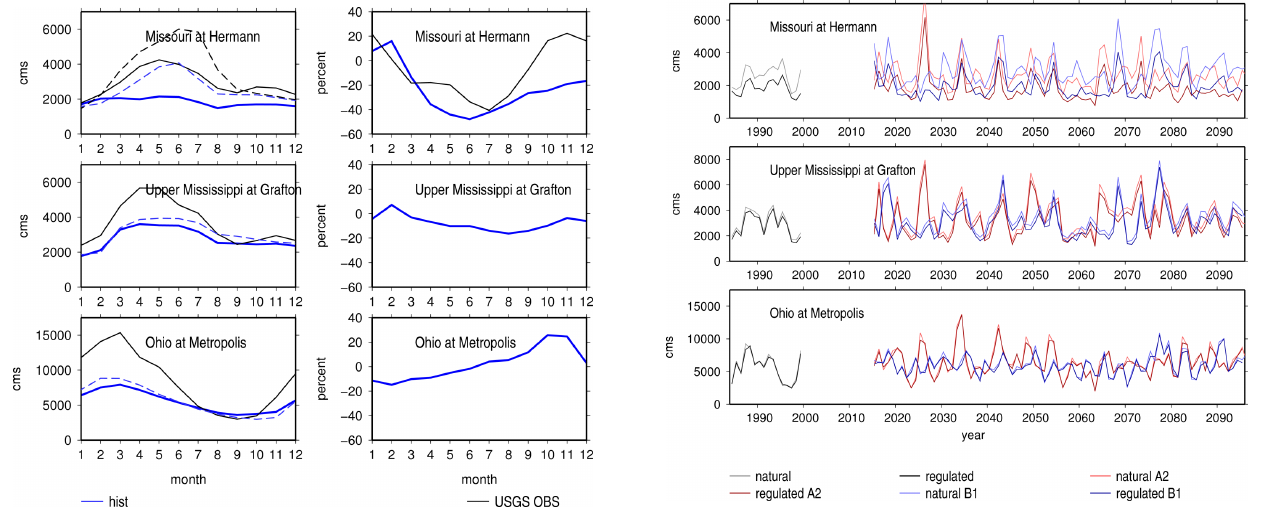
Figure 7: Simulated natural (dashed) and regulated (solid) flow (left column) and relative change in flow due to 2 regulation (right column) over the three Midwestern regions: Missouri, Upper Mississippi and Ohio for the historical 3 Fig. 6. Simulated natural (dashed) and regulated (solid) flow (left (1984-99) 4 column) and relative change in flow due to regulation (right column) over the three US Midwestern regions: Missouri, Upper Mississippi and Ohio river basins for the historical period 1984–1999.